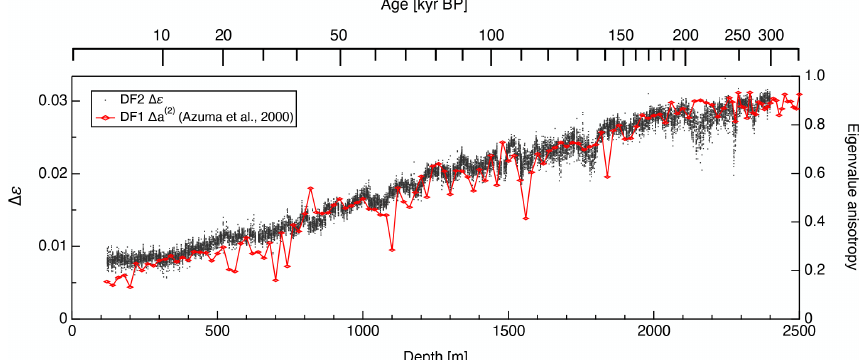
Figure 6. A modified version of the data in Fig. 5a. The raw (cid:49)ε values at each 0.02m step are shown instead of means over each 0.5m. The scatter of the thin-section-based data (red symbols and lines) is far larger than that of the thick-section-based data.